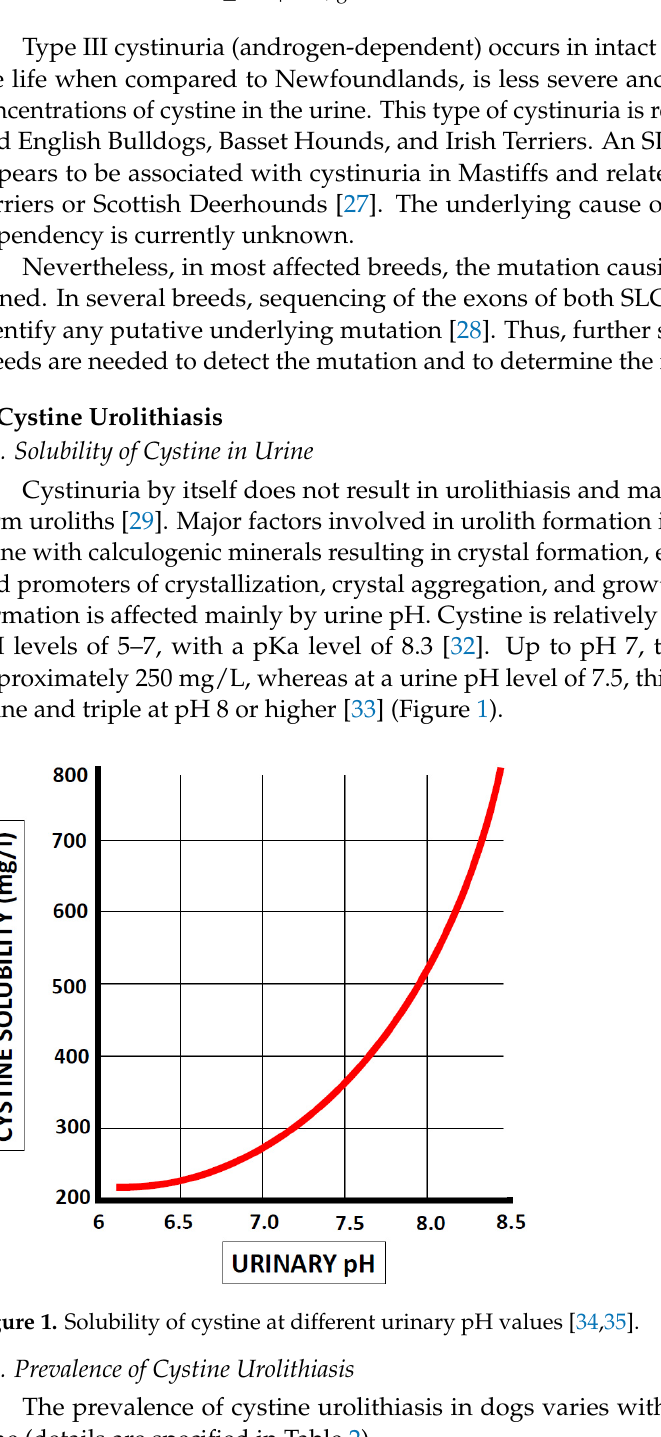
The prevalence of cystine urolithiasis in dogs varies with geographic location and time (details are specified in Table Table 2. Prevalence of cystine urolithiasis in dogs by region and characteristics of affected dogs in various studies. Location